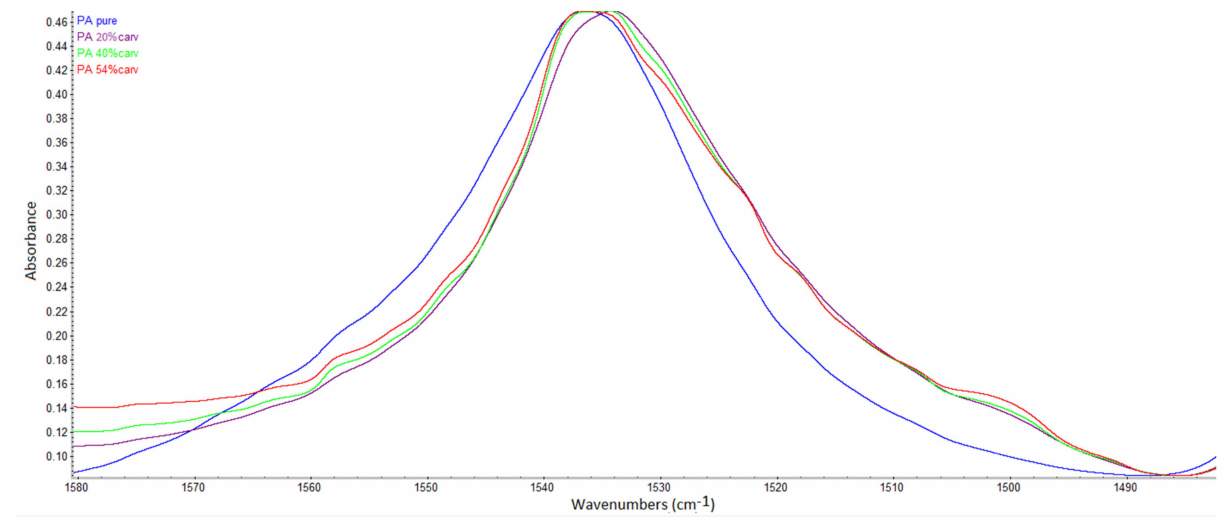
Figure A7. N–H bending vibration band in neat and carvacrol-impregnated polyamide membranes.